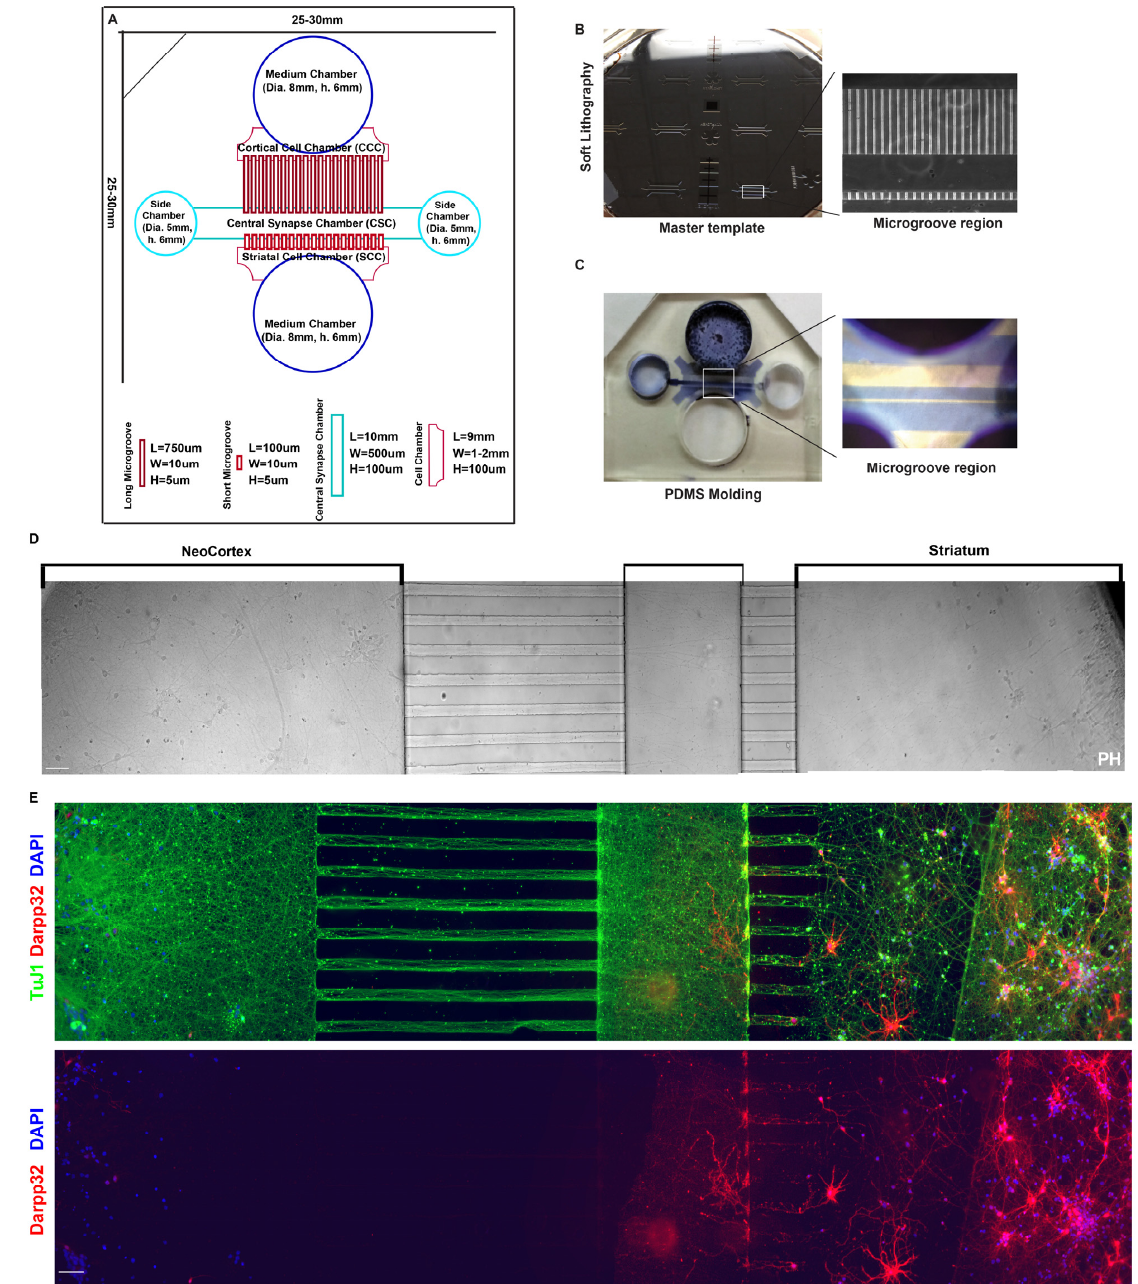
Figure 2. Design and Fabrication of Cortical–Striatal Neuronal Microfluidic Chamber. ( A ). Photo- graph of the chambers’ AutoCAD design with detailed numbers. ( B ). Photograph of the master template, a 100 mm silicon wafer of crosslinked SU8 negative resists, containing microfluidic chan- nel features. Inset from ( B ) showing detail of long (750 µm, for axon isolation) and short (100 µm, for dendrite isolation) microgrooves separated by a central chamber. ( C ). Low power (5 ×) image of cut PDMS microfluidic chamber. Inset from ( C ) showing cell culture areas in blue and microgrooves in white. Microfluidic chamber with directional cortico-striatal co-culture. ( D ). Differential interfer- ence contrast (DIC) to show neurons growing in chamber. ( E ). Further confirmation of neuron in chamber via immunostaining. Microtubule (TuJ1) staining reveals axons growing through the chamber grooves (Top). The DARPP-32 striatal neuron marker confirms the cortex and striatum separation across the left and right chambers (Bottom). Scale bar is 100 µm.